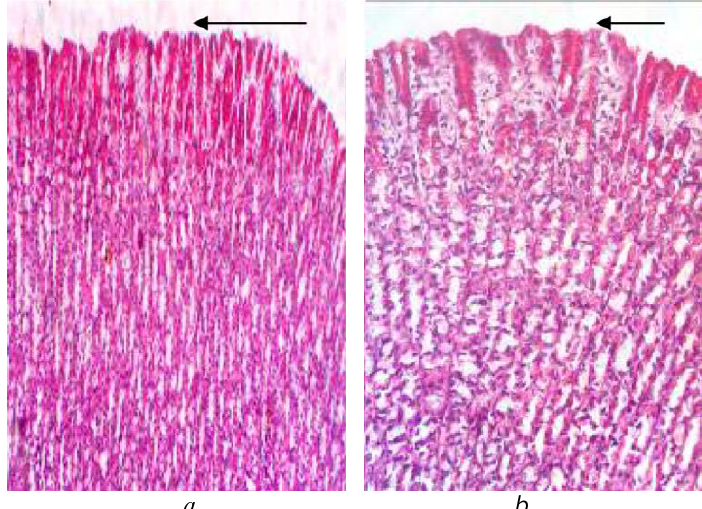
Fig. 15. The stomach of the rats, which were injected Altan at a dose of 1 mg/kg on the background of alcohol- prednisolone mixture: different expression PAS-positive reaction ( a – normal; b – reduced) in prepyloric part of the mucous membrane. PAS-reaction.